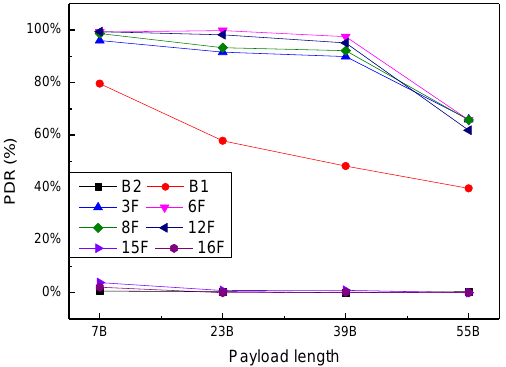
Figure 16. Relationship between PDR and payload length in the different floors.